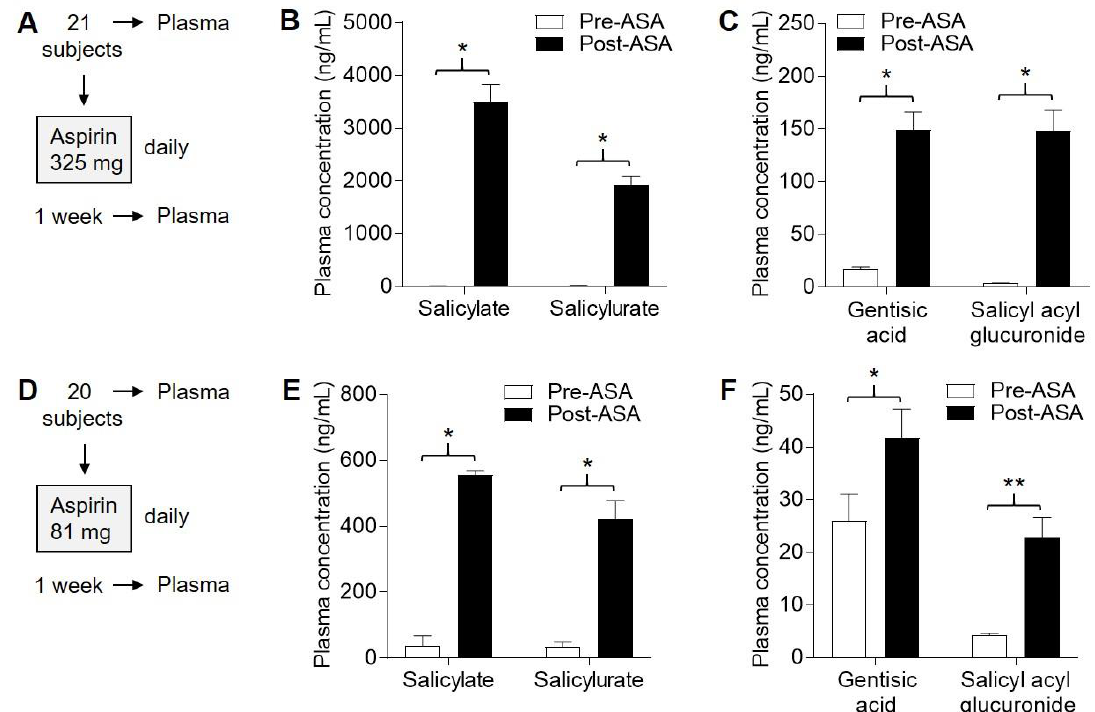
Figure 4. Detection of ASA metabolites in plasma following 1 week of daily ASA exposure. Human subjects were each given ASA daily for one week, and tissue samples were obtained both before (pre) and after (post) this period. ( A ), Protocol for 325 mg dosing. ( B ), Levels of salicylate and salicylurate in plasma in the 325 mg cohort. * p < 0.0001, paired t -test. ( C ), Levels of gentisic acid and salicyl acyl glucuronide in plasma in the 325 mg cohort. * p < 0.0001, paired t -test. ( D ), Protocol for 81 mg dosing. ( E ), Levels of salicylate and salicylurate in plasma in the 81 mg cohort. * p < 0.0001, paired t -test. ( F ), Levels of gentisic acid and salicyl acyl glucuronide in plasma in the 81 mg cohort. * p = 0.04, ** p < 0.0001, paired t-tests.